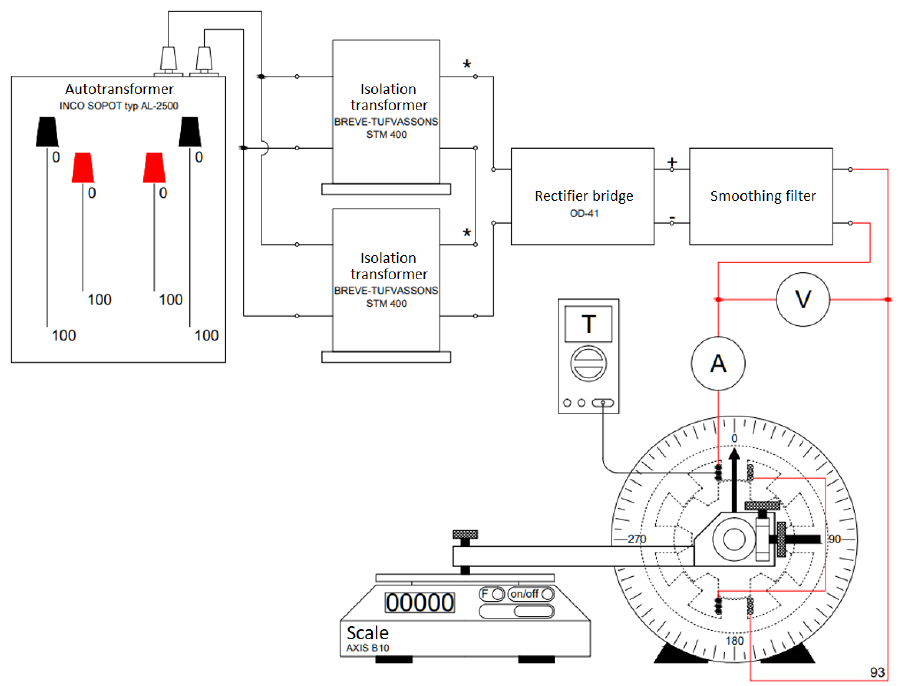
Figure 7. Diagram of the measuring system used for motors tests.